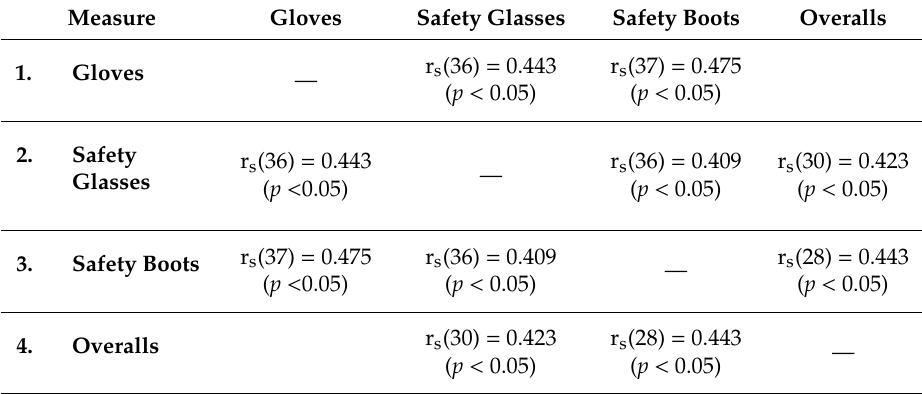
Table 4. Spearman’s rank-order correlation (r s ) frequency between simultaneous use of PPE.